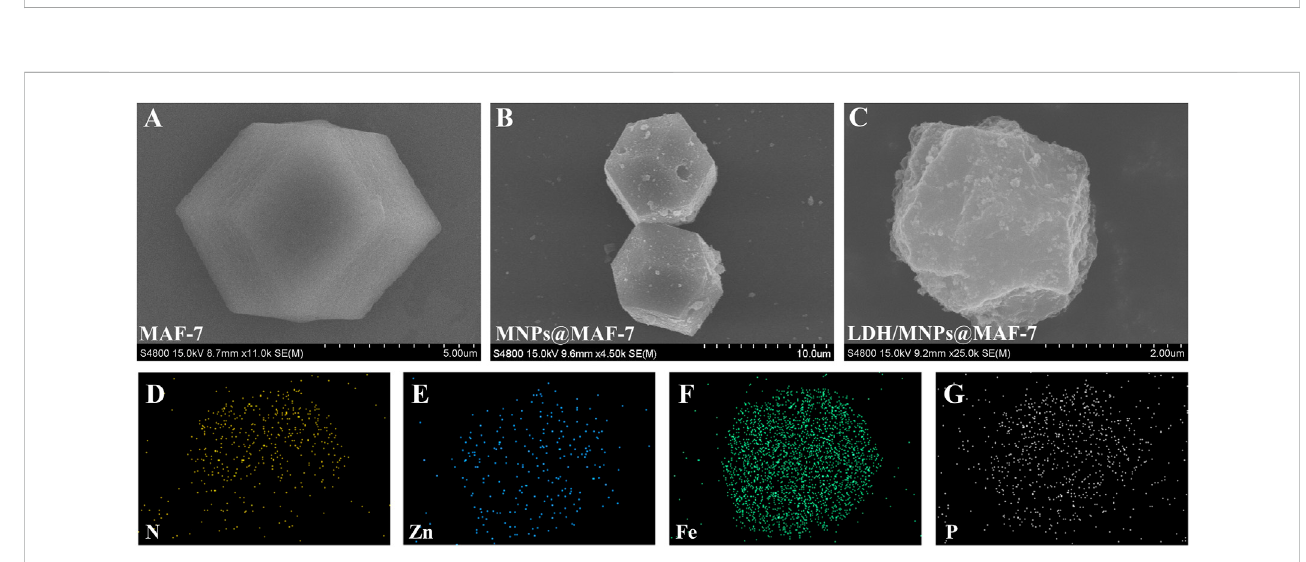
FIGURE 2 SEM spectra of (A) MAF-7 (B) MNPs@MAF-7, and (C) LDH/MNPs@MAF-7; elemental mapping (D – G) of